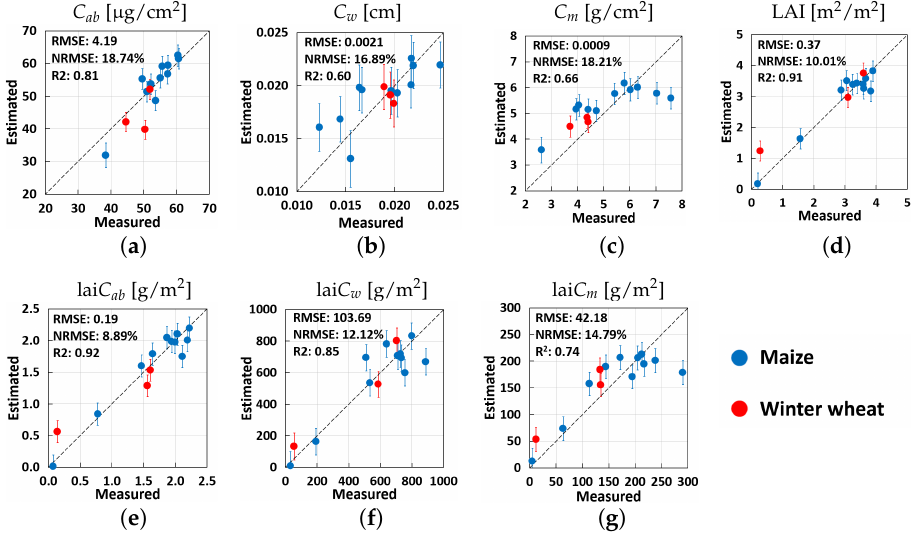
Figure 3. NRMSE ( left ) and R 2 ( right ) for several trait estimations using the EBD-GPR retrieval model. The optimal number of training samples for the best performance point (marked with an asterisk) is provided in parentheses.